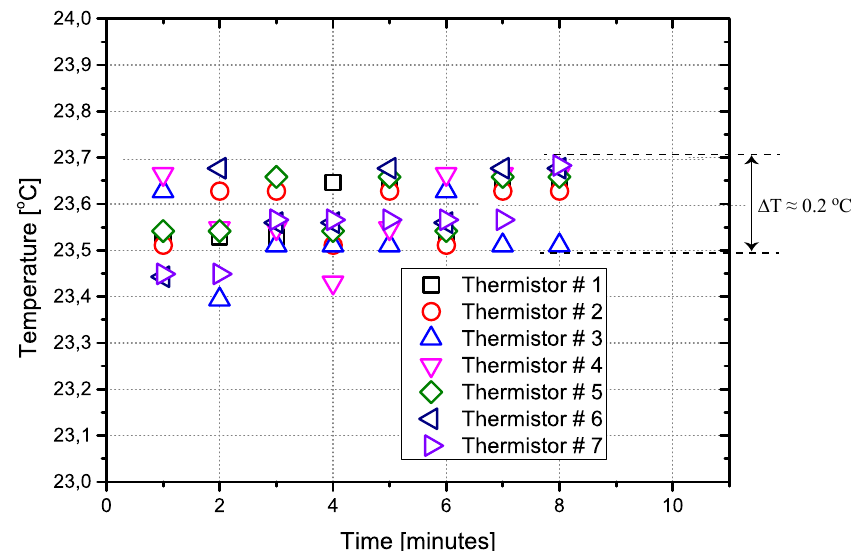
Figure 4. Measured values of temperature in the seven thermistors, left at room temperature.